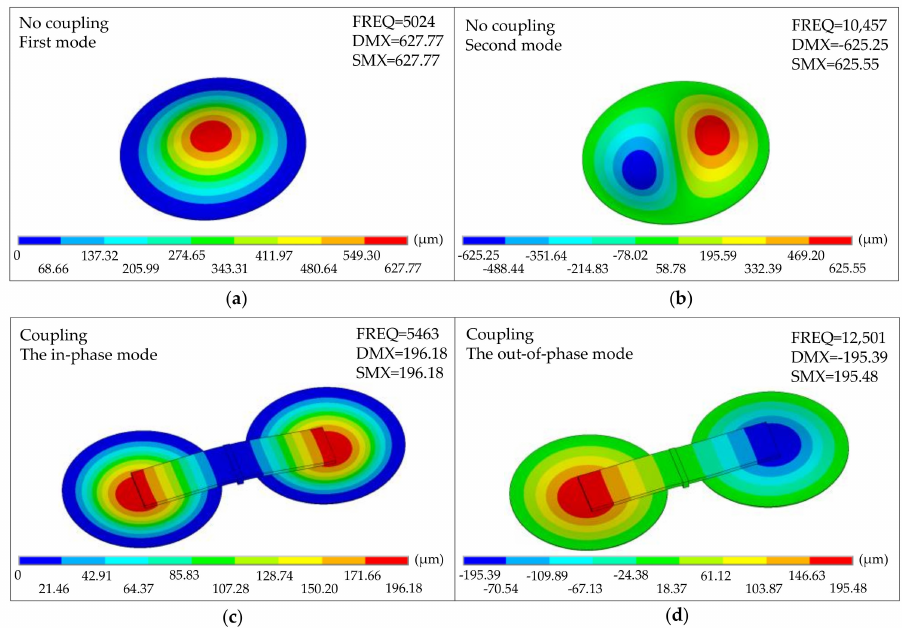
Figure 10. The modal characteristics of the bio-inspired structure. ( a ) The first mode of the non-coupling structure. ( b ) The second mode of the non-coupling structure. ( c ) The in-phase mode of the coupling structure. ( d ) The out-of-phase mode of the coupling